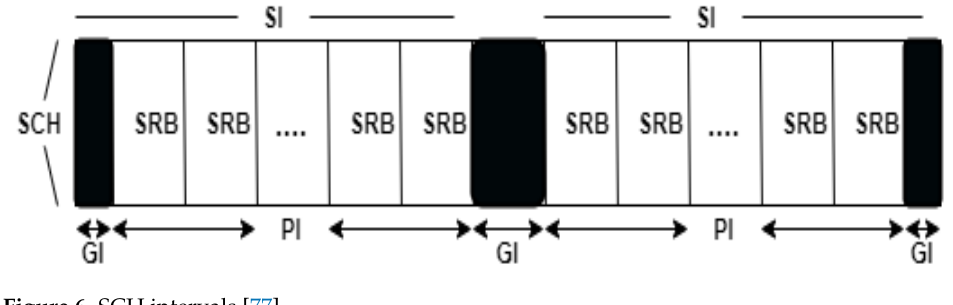
Figure 6. SCH intervals